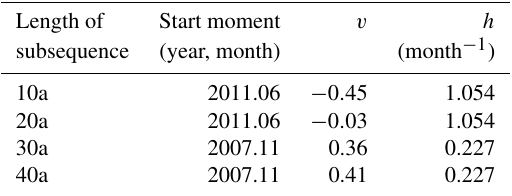
Table 2. Parameters v and h have been obtained with different sub-